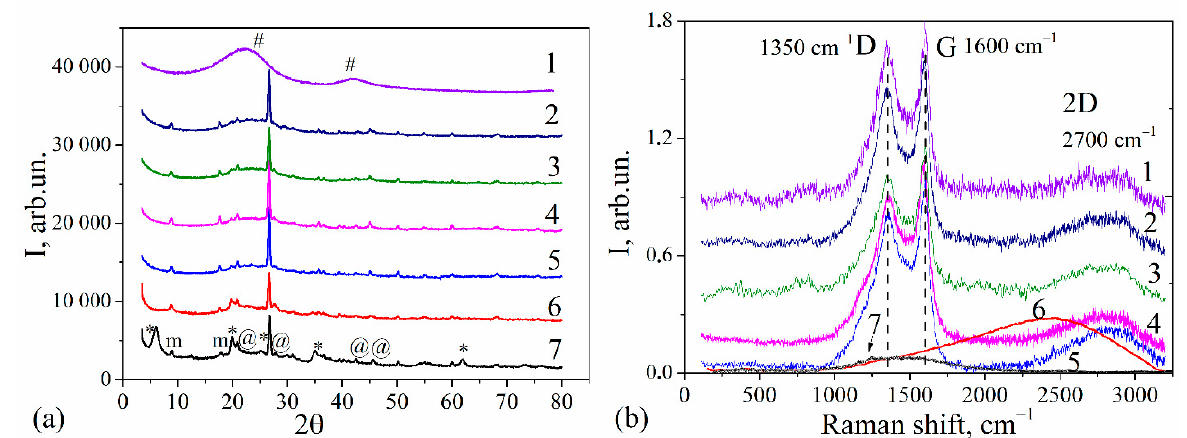
Figure 1. X-ray diffraction patterns ( a ) and Raman spectra of the pyrolyzed materials ( b ): 1—TC